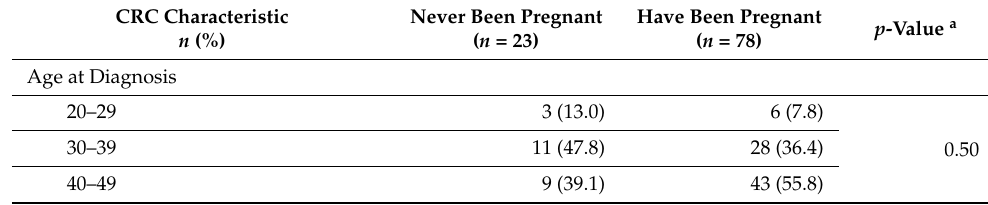
Table 2. CRC characteristics according to pregnancy